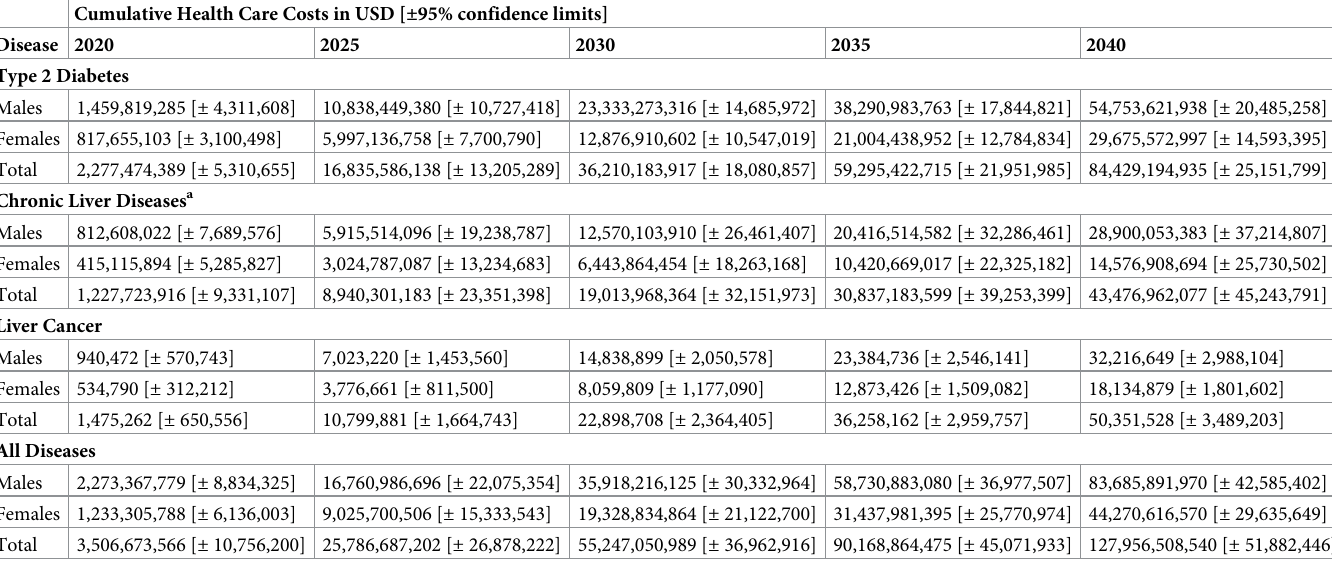
Table 3. Obesity-attributable health care costs between 2020 and 2040 amongst the Saudi Arabian working population (20–59 years). Cumulative Health Care Costs in USD [ ± 95% confidence limits] Disease